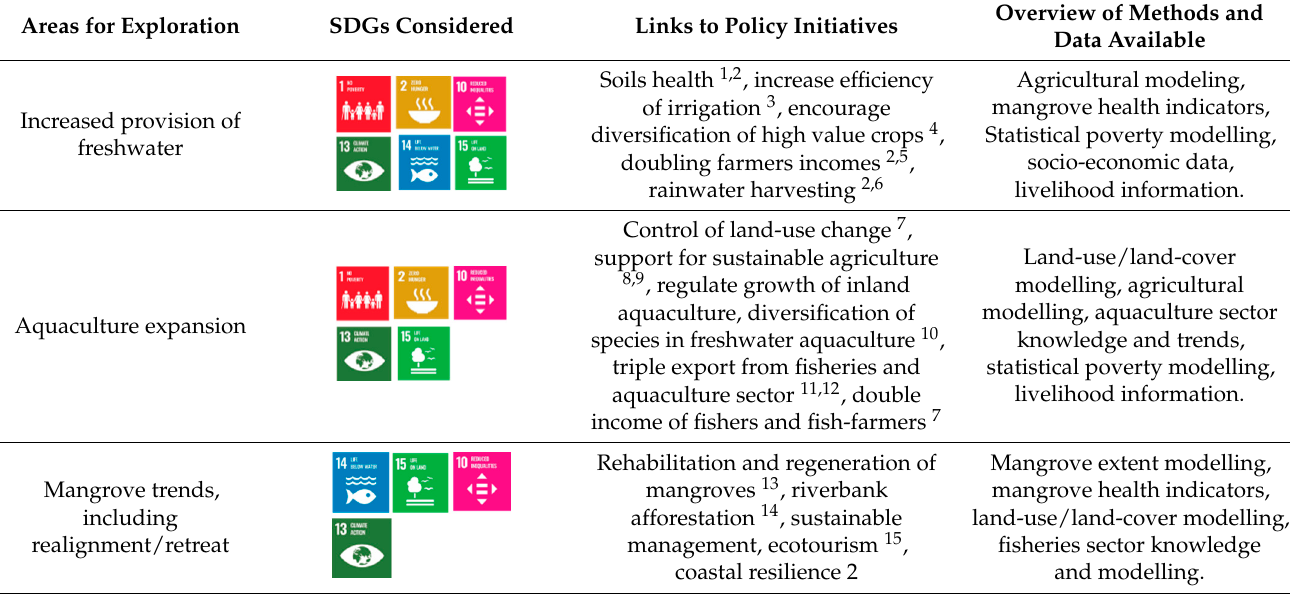
Table 2. Summary of key issues to explore within the SBR, their links to SDGs and current policy, and overview of the type of methods and data available for analysis.